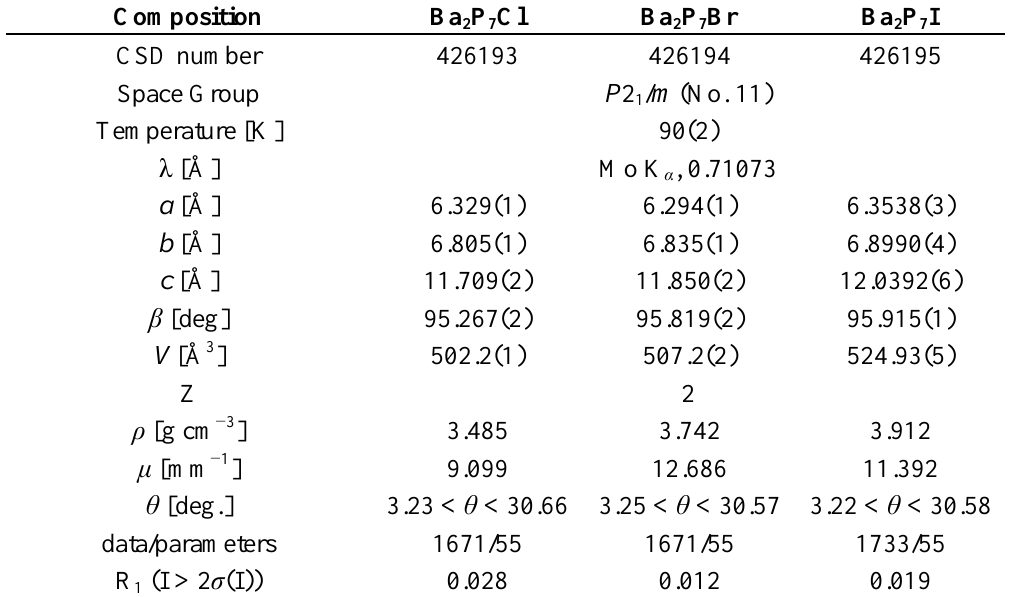
P X (X = Cl, Br, I). 2 7